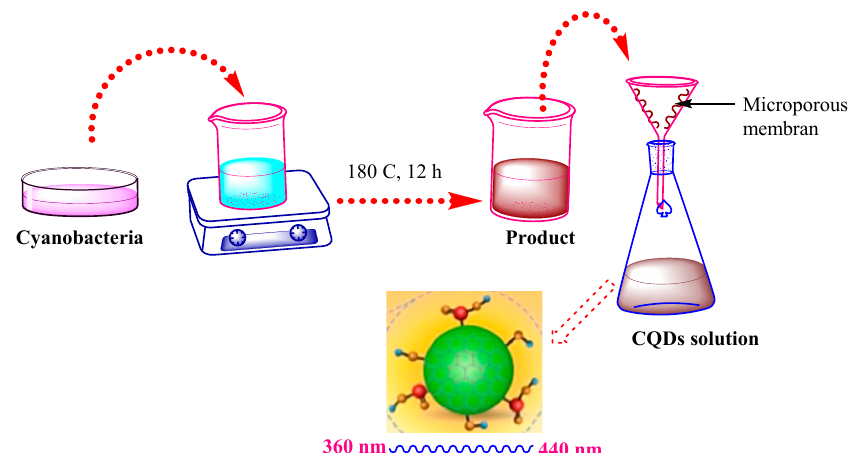
Figure 6. Specific synthesis of CQDs from cyanobacteria species.